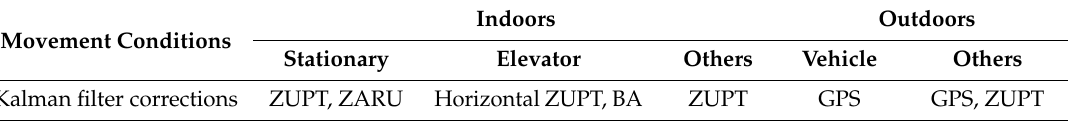
Table 1. Correspondence between di ff erent movement conditions and Kalman filter corrections. Movement